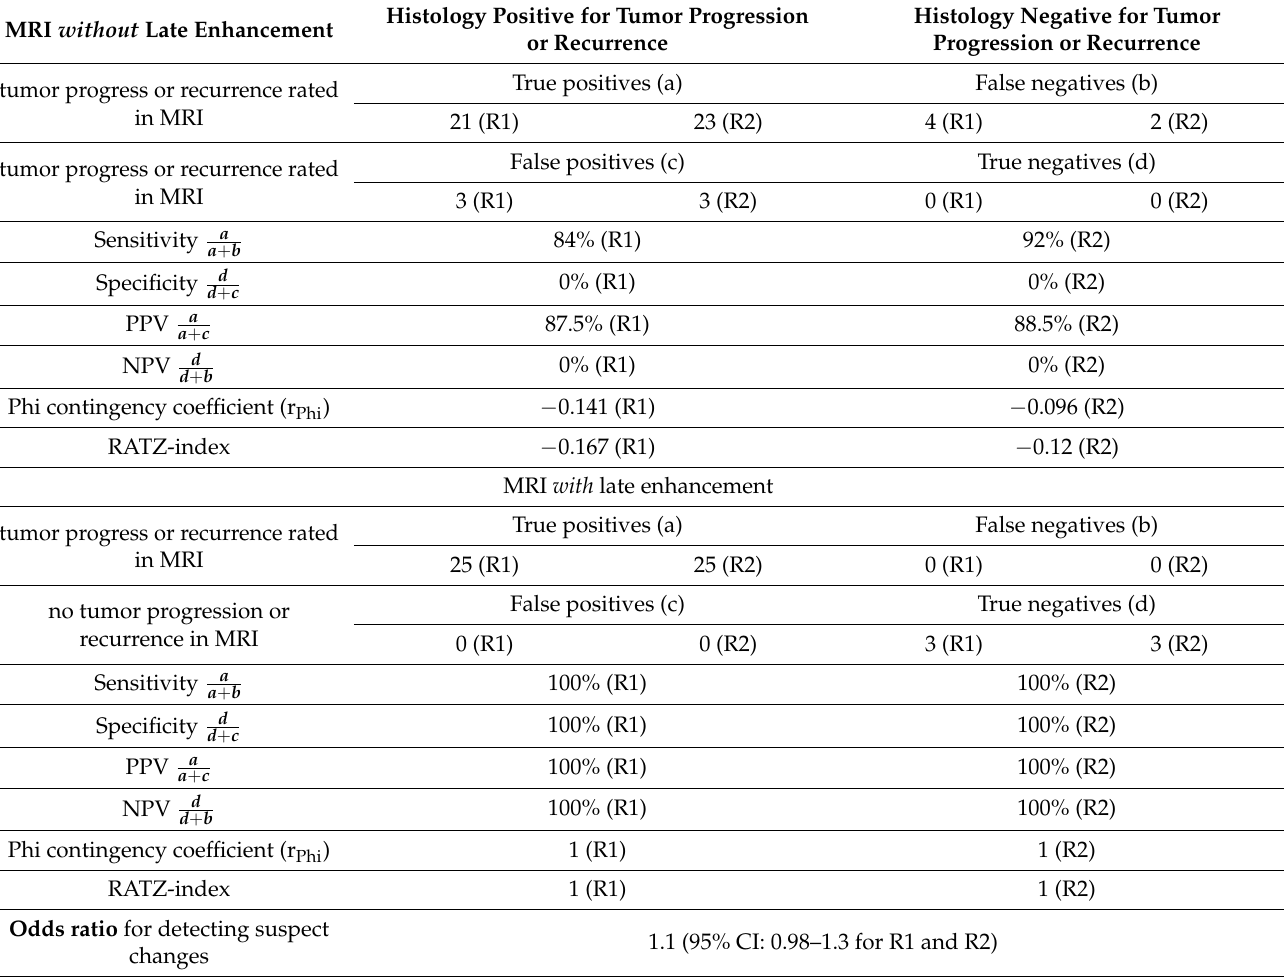
Table 1. Chi-square